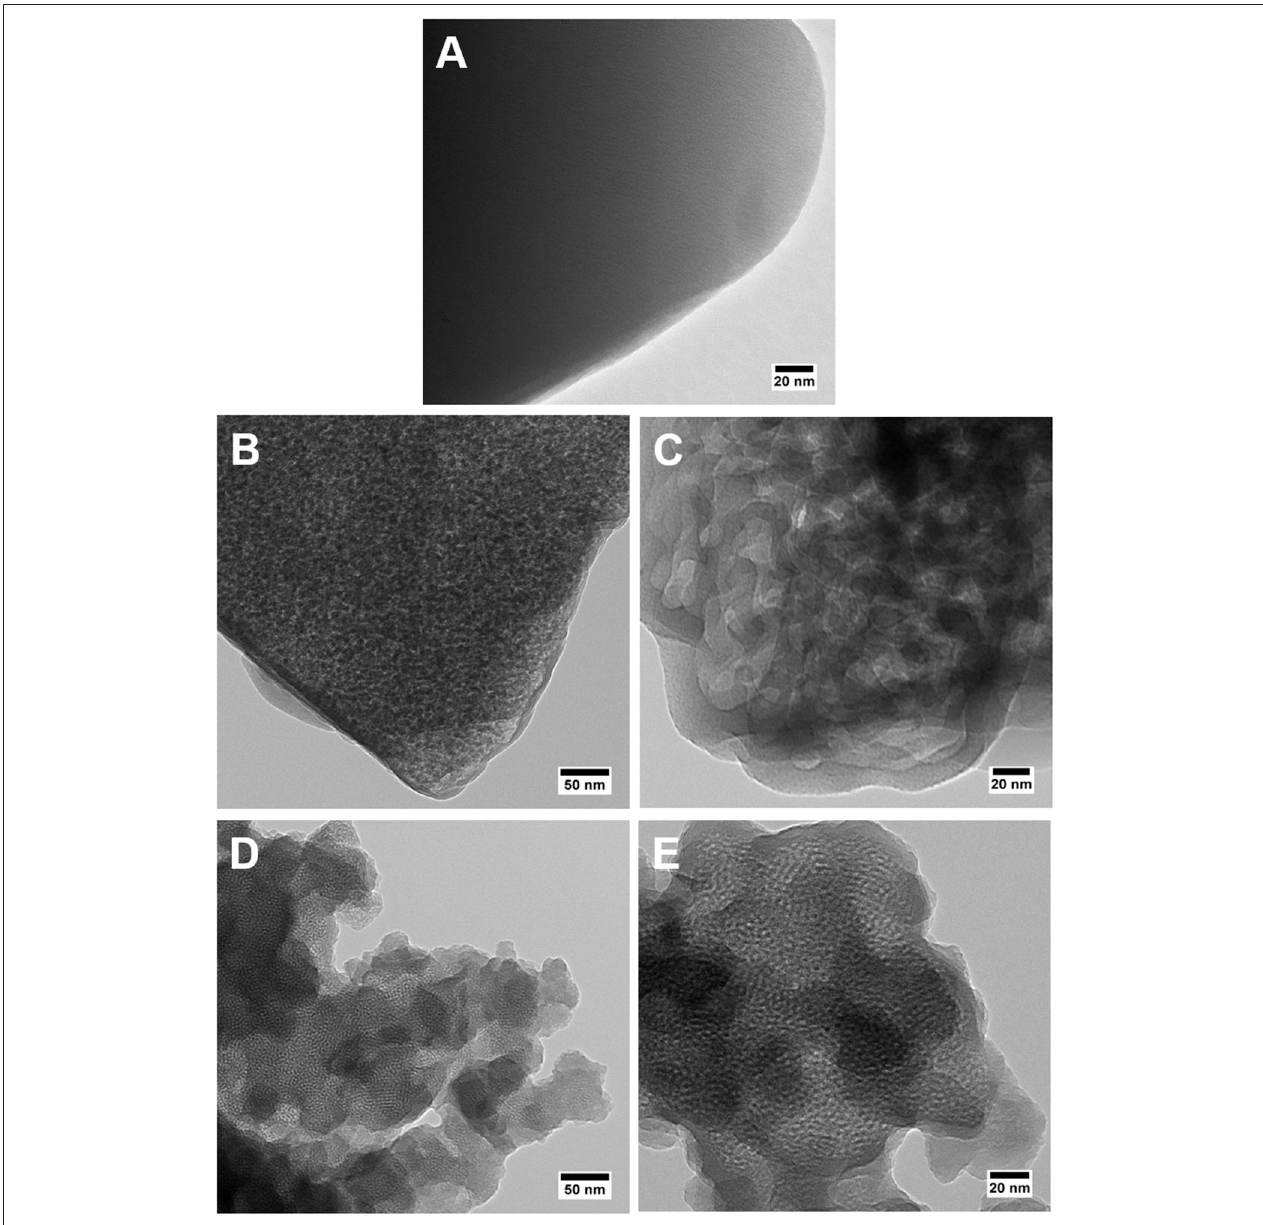
FIGURE 3 | TEM micrographs of (A) zeolite Y, (B,C) MZM-MW-1m-100, and (D,E)